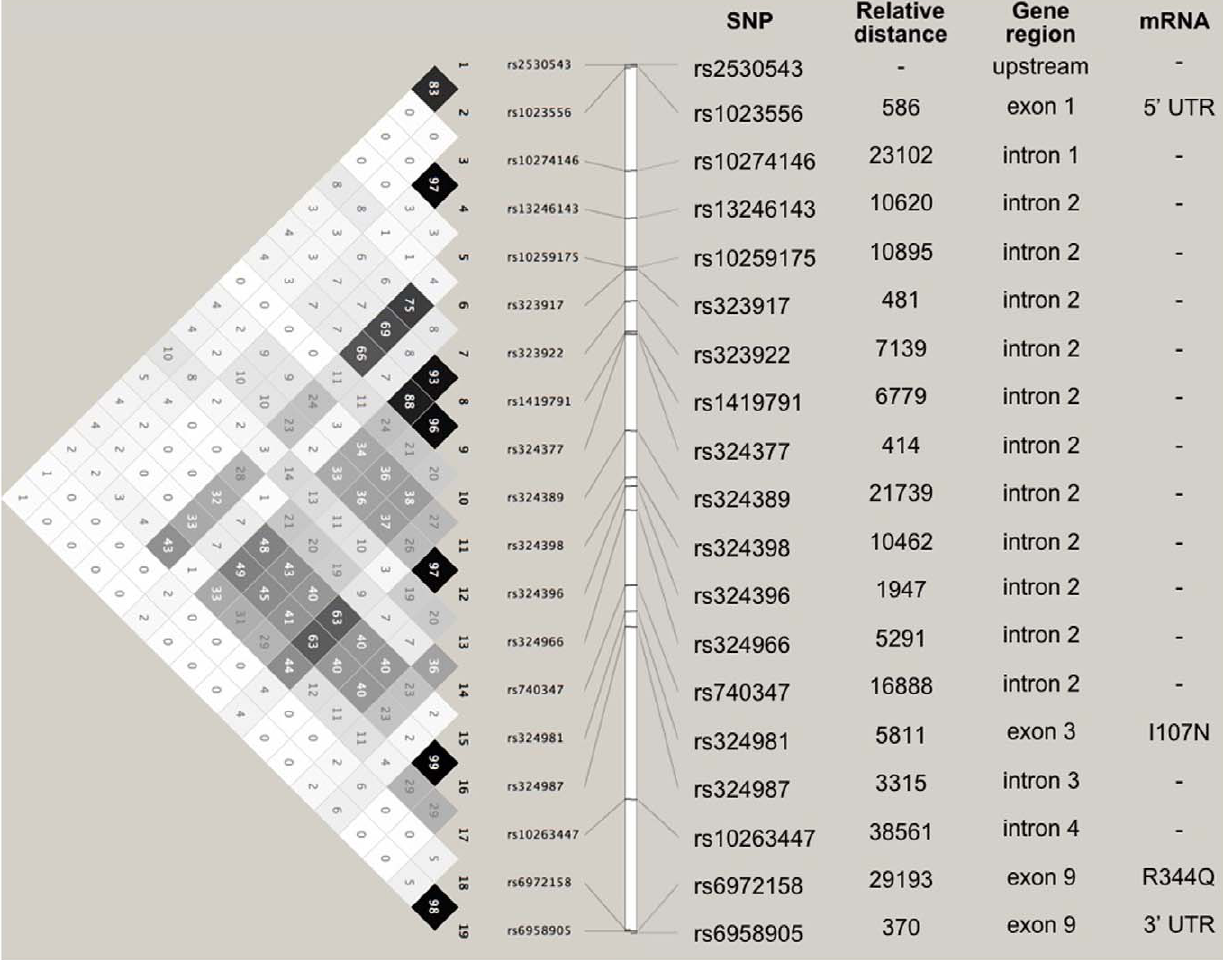
Figure 1. LD map and characteristics of the studied NPSR1 SNPs. Left: LD and haplotype block structure obtained by Haploview 4 analysis of genotyping data from the EIRA population. The numbers in each box correspond to R-square values between SNPs. Right: SNPs are listed based on their relative distance in bp and their position in both the NPSR1 gene and its corresponding mRNA).